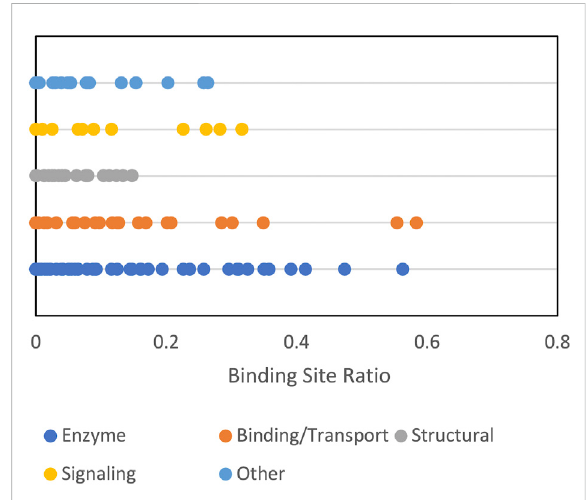
FIGURE 9 Funnel size by protein function category. The funnel